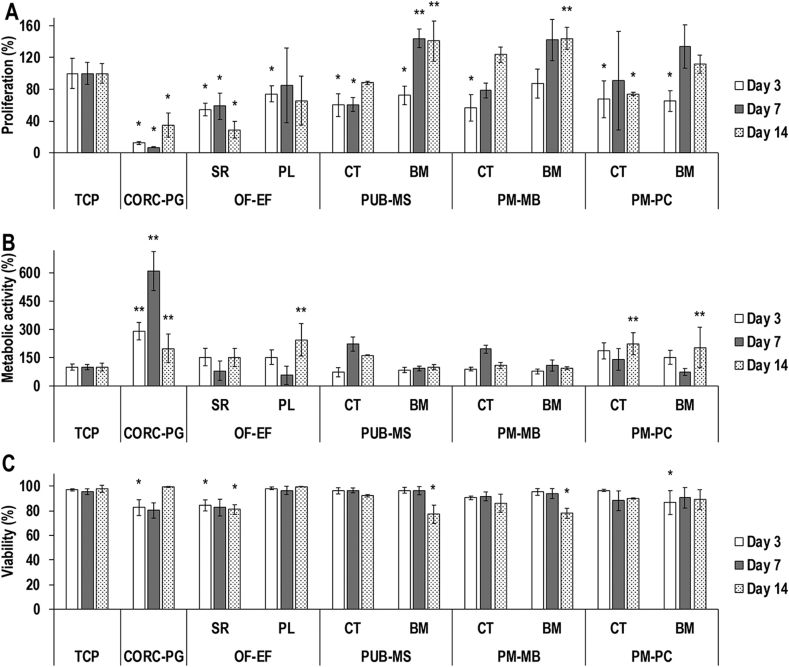
By day 14, the lowest (∗p<0.05) dermal fibroblast proliferation was detected for the CORC-PG, SR side of the OF-EF, and the CT side of the PM-PC, whereas the highest (∗∗p<0.05) dermal fibroblast proliferation was detected for the BM sides of the PUB-MS and PM-MB (A). By day 14, the CORC-PG, the PL side of the OF-EF, and both sides of PM-PC exhibited the highest (∗∗p<0.05) dermal fibroblast metabolic activity (B). By day 14, the SR side of the OF-EF, the BM side of the PUB-MS, and the MB side of the PM-MB showed the lowest (∗p<0.05) dermal fibroblast viability, although all groups exhibited viability higher than 75% (C). Data expressed as average ± standard deviation (n = 3). Samples were compared to the control TCP at a given time point.